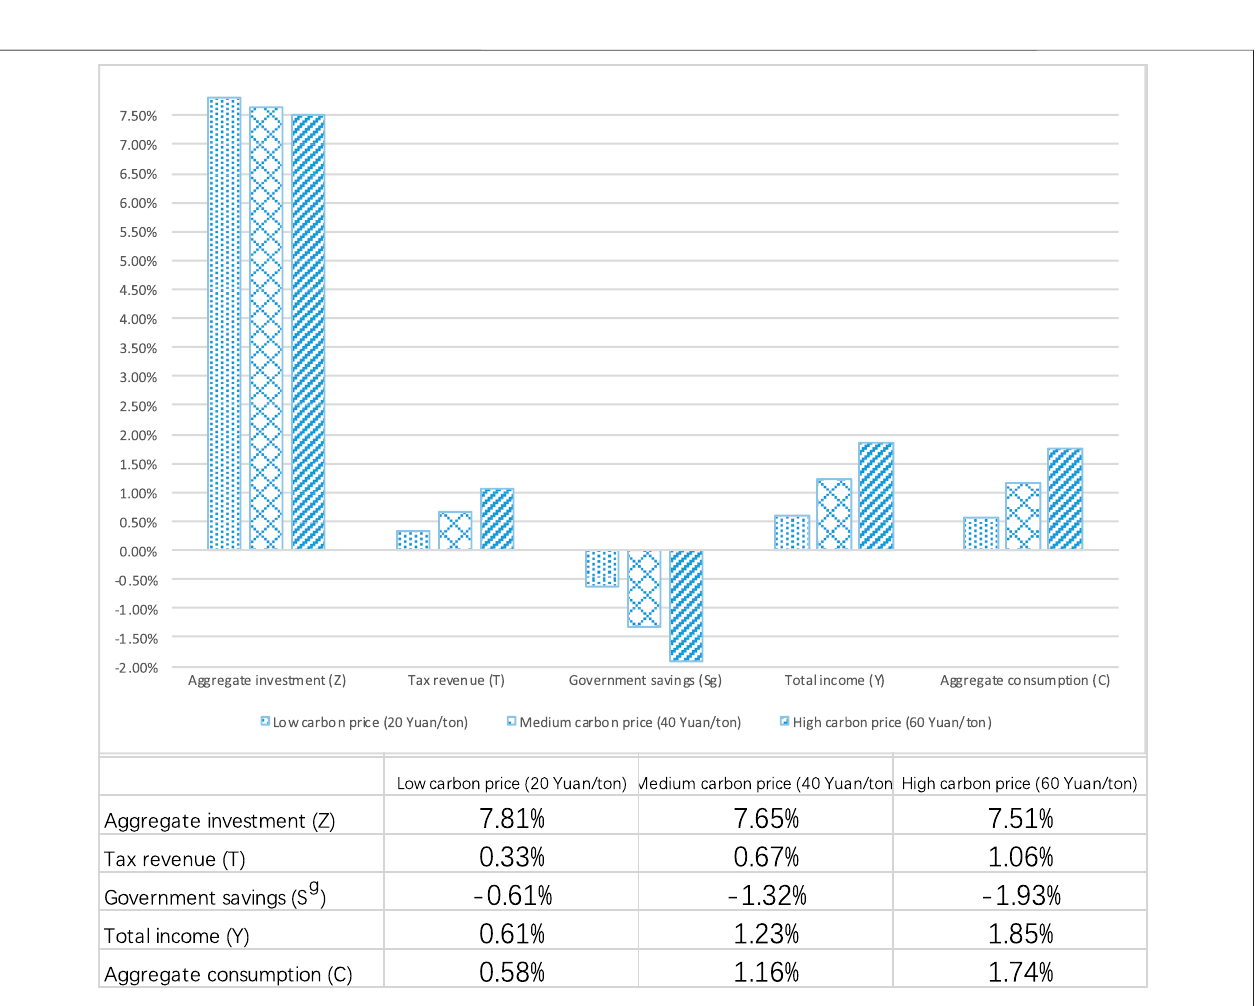
FIGURE 4 | Impact on macroeconomic variables in a carbon trading policy